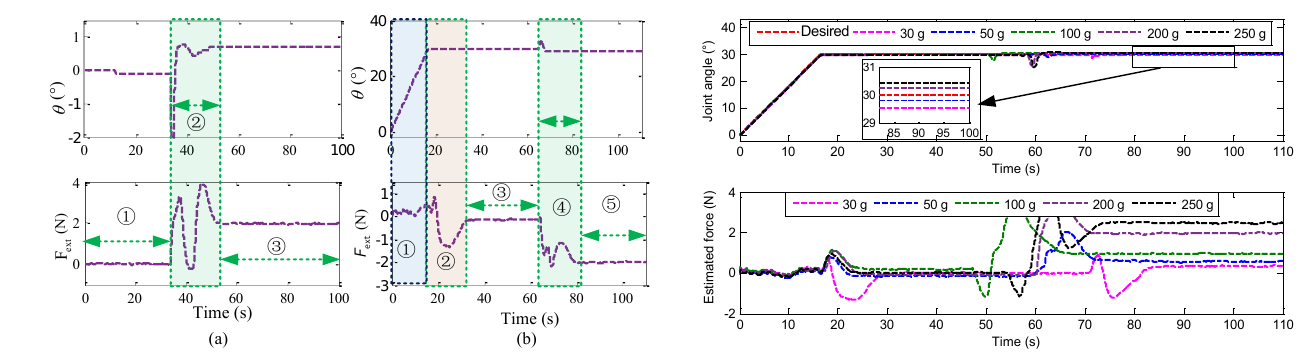
Figure 24. Positive direction loading experiment results at 30 ◦ .